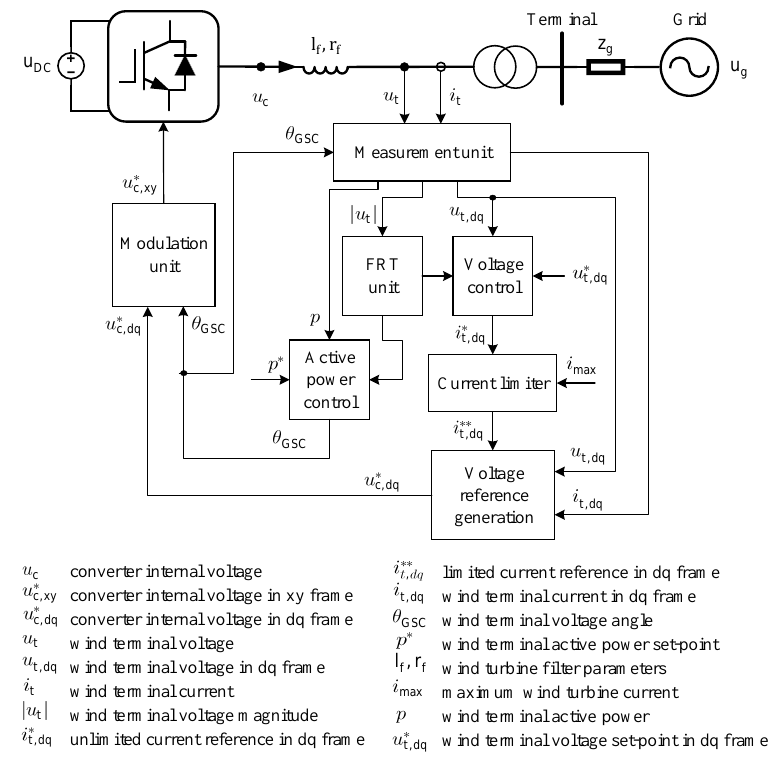
Figure 9. Single line and control block diagram of a grid-forming converter. All variables are in